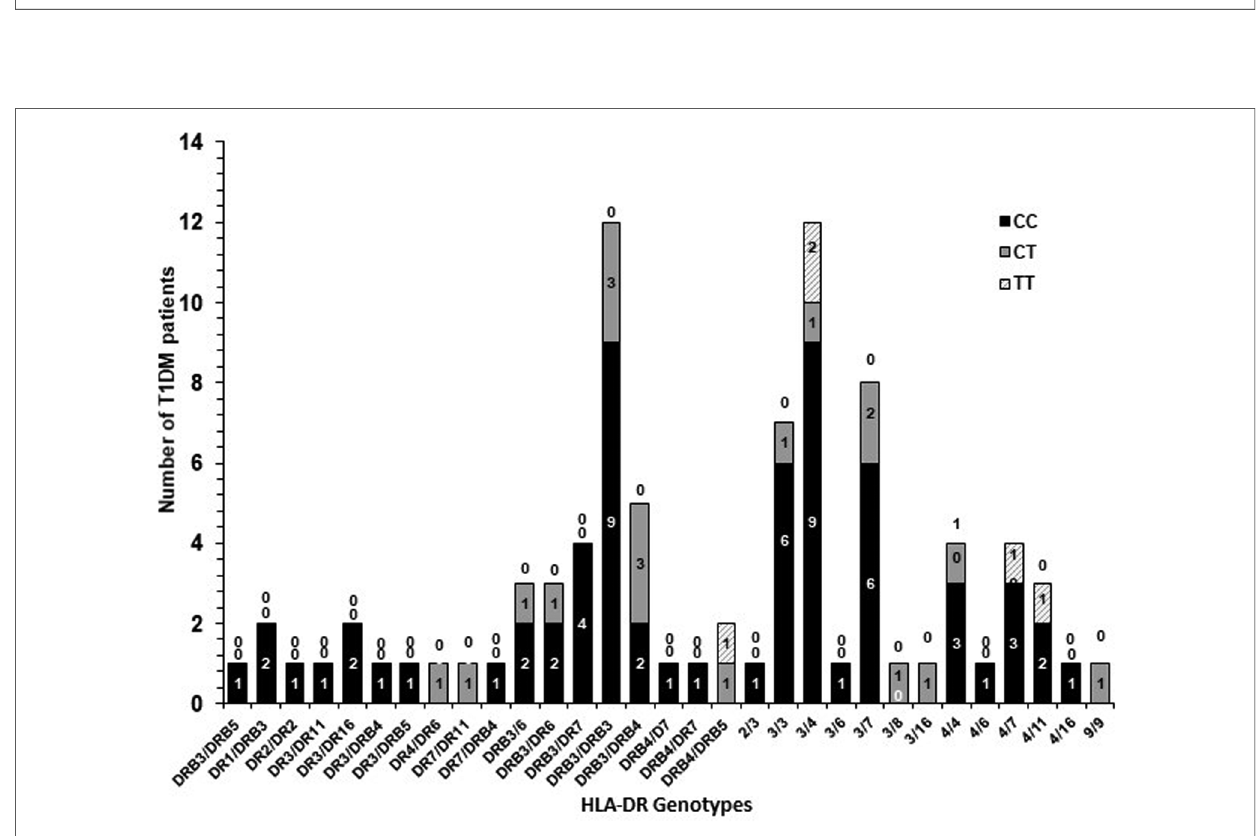
FIGURE 4 Co-inheritance of IL4 gene – C590T polymorphism genotypes with HLA-DR genotypes in Kuwaiti T1DM patients. “ 0 ” above the bars indicate the absence of a particular genotype. The shaded bars show the co-inheritance with various HLA-DR